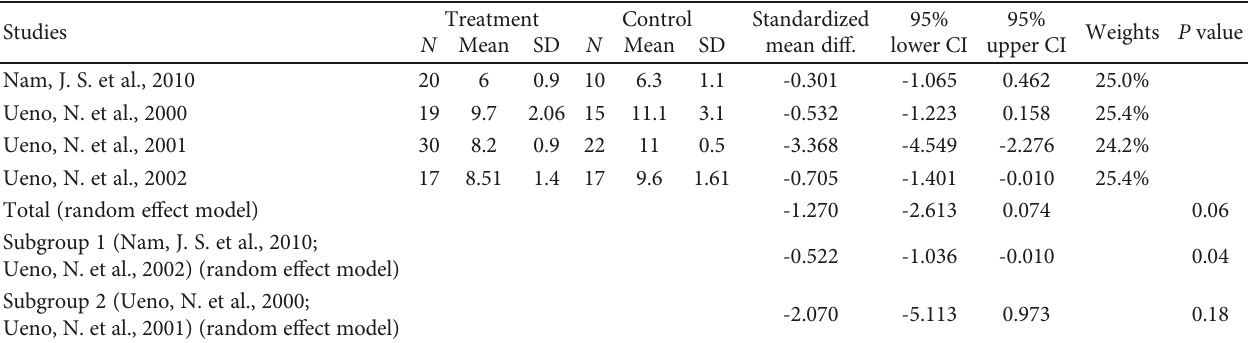
Figure 2: The results of the meta-analysis for HbA1C. Table 4: The results of meta-analysis for fasting blood glucose.